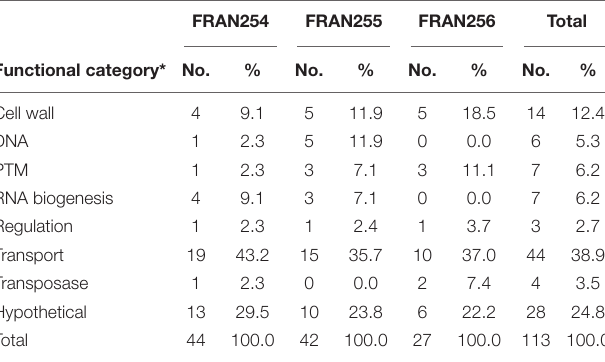
TABLE 2 | Frequency of mutations and their functional categories in FRAN254, FRAN255, and